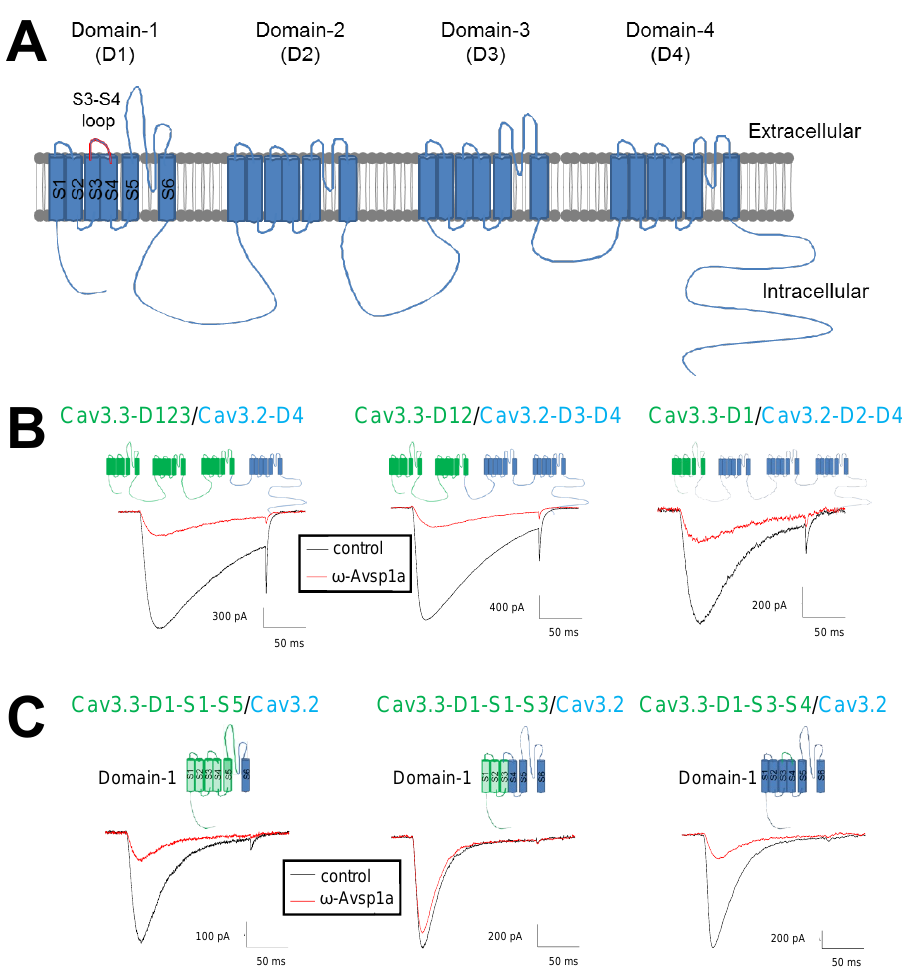
Figure 5. Activity of native ω -Avsp1a on Ca V 3 chimeras expressed in HEK-293 cells. ( A ) The pore-forming α 1-subunit of Ca V 3 channels is comprised of four homologous domains (D1, D2, D3, D4),